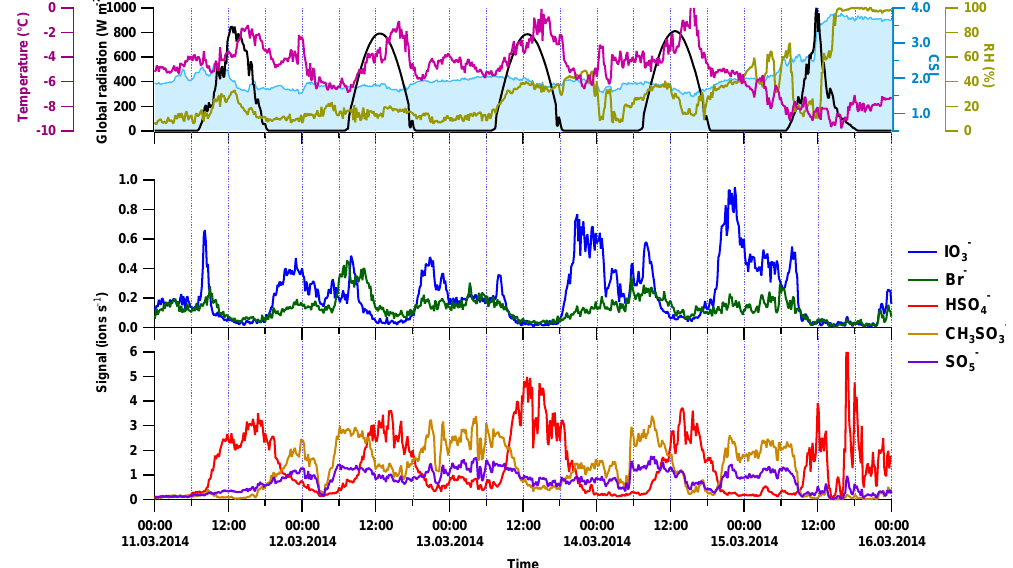
Figure 6. Time series from 11 to 16 March illustrating halogen chemistry. Global radiation, RH and cloud coverage are shown in the top panel. The decrease in signal of Br − and IO − during noon in the middle panel implies photochemical reactions on the precursors of these 3 ions or charge distribution. The lowest panel shows the anticorrelation of sulfuric acid with CH 3 SO −